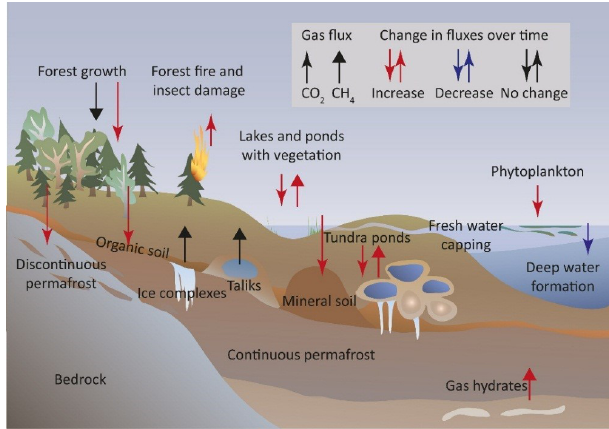
Figure 6. Carbon cycling in the Arctic will change as the climate warms. Figure after ACIA, 2004 (Arctic Climate Impact Assess- ment,